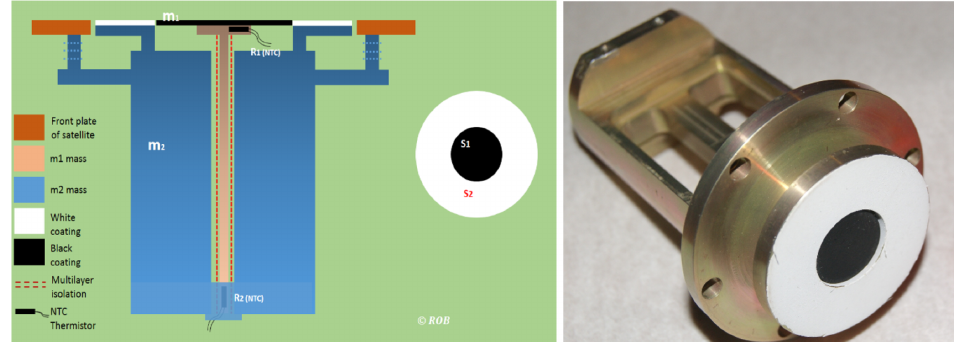
Figure 2. The sketch of the BOS. The detector ( m 1 ) is connected to the heat sink ( m 2 ) by a thin shunt, which is thermally isolated from m 2 by multi-layer isolation (MLI). The instrument unit is installed in the front panel of the spacecraft through a high thermal resistance Vespel ®